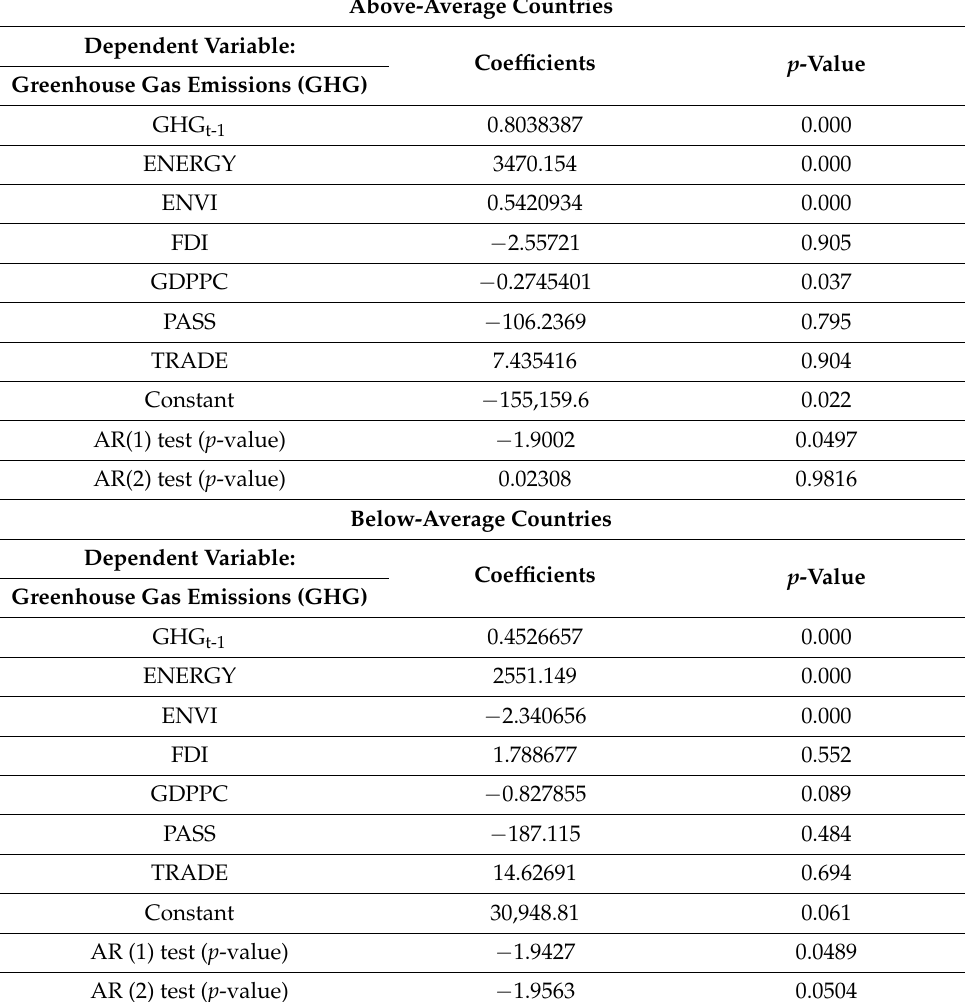
Table 7. Arellano and Bond dynamic panel analysis. Source: